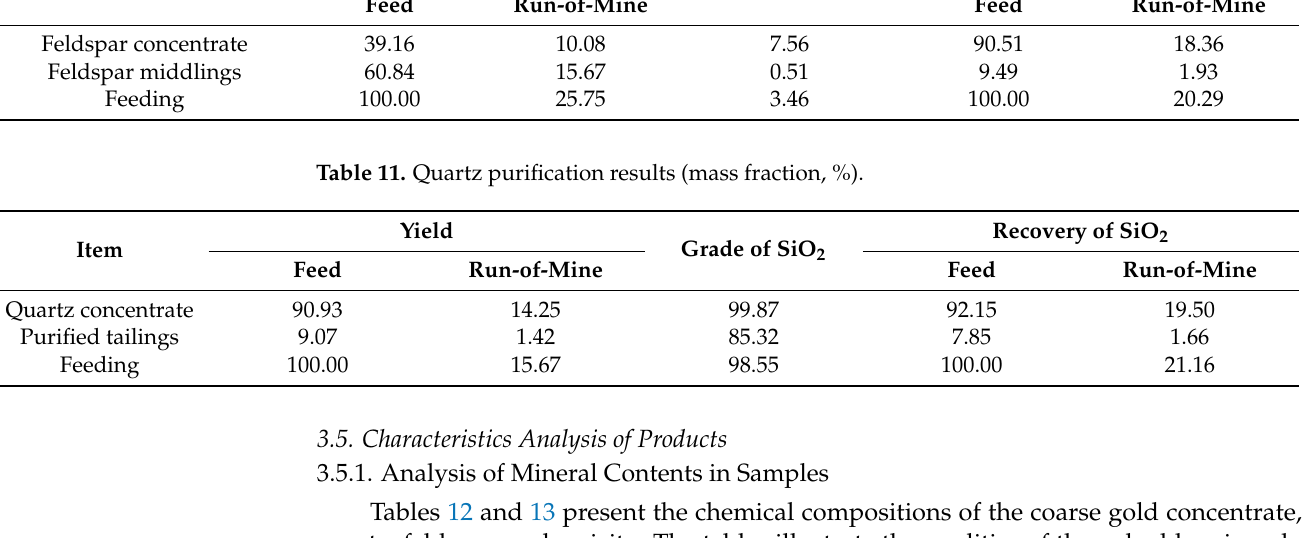
Figure 9. Flotation flowsheet for recovery of feldspar and purification of quartz.